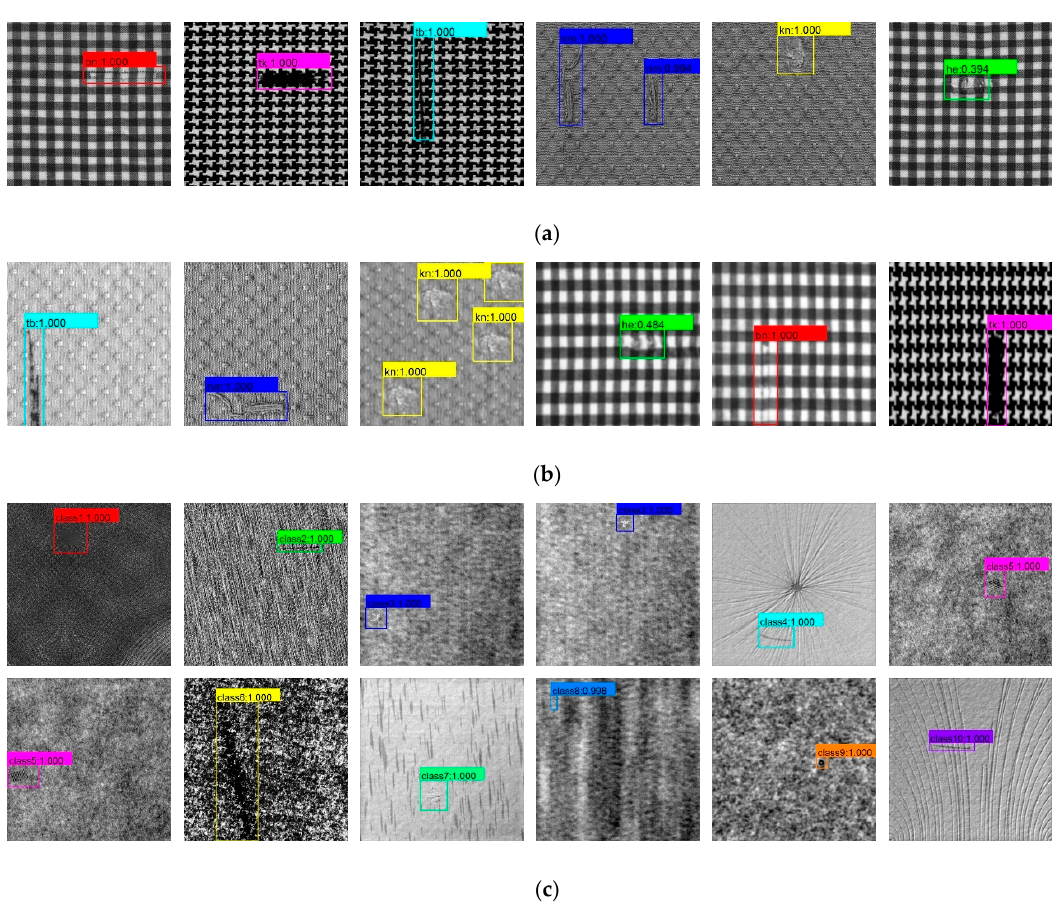
Figure 14. The partial detection result of the proposed method. ( a ) The detection result of the proposed method on Hong Kong testing set; ( b ) The detection result of the proposed method on Hong Kong testing set with interference; ( c ) The detection result of the proposed method on DAGM2007 testing set.